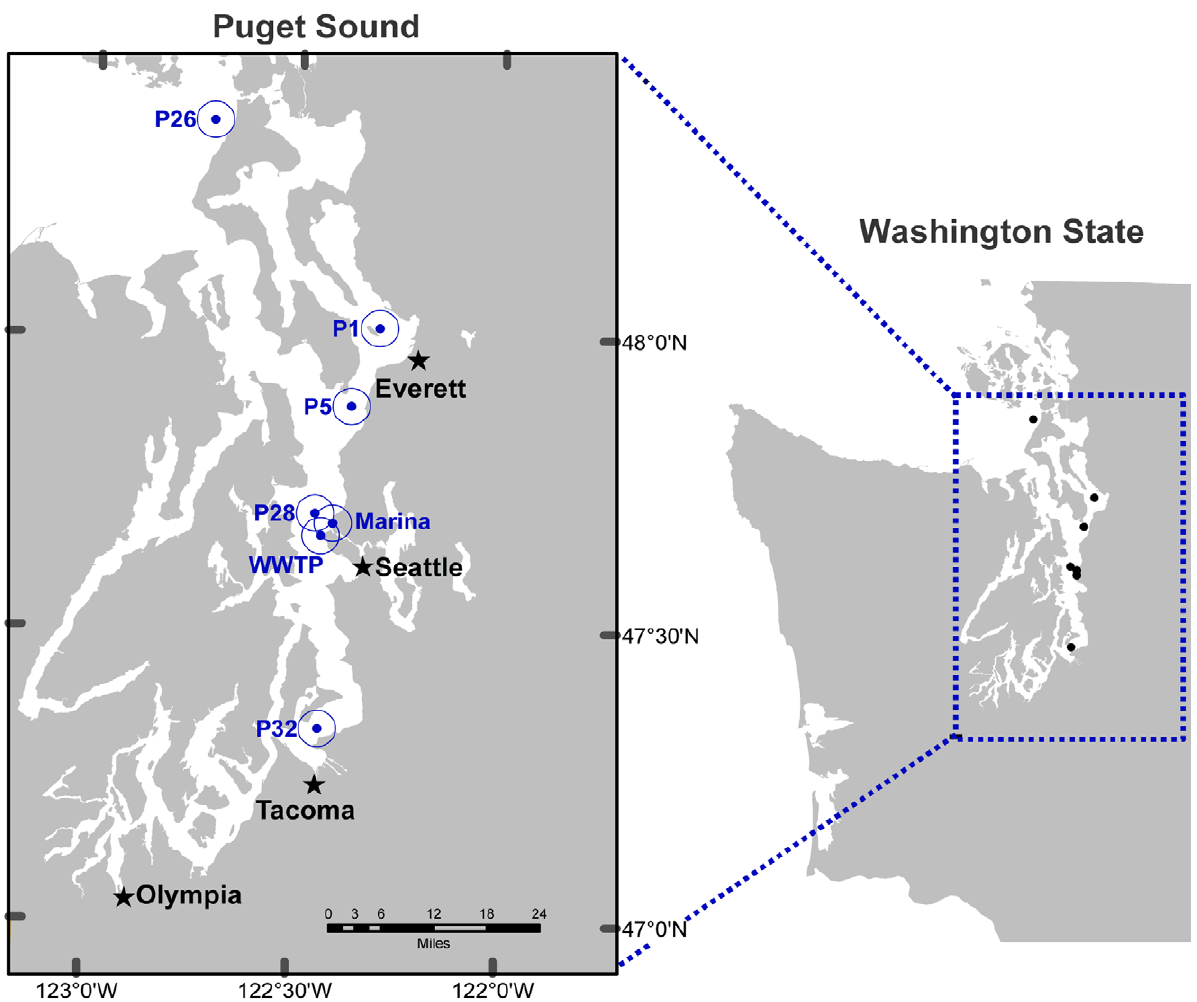
Figure 1. Locations of sampling sites in Puget Sound. Refer to Table 1 for the geographic coordinates of the sampling stations. WWTP, Wastewater treatment plant.